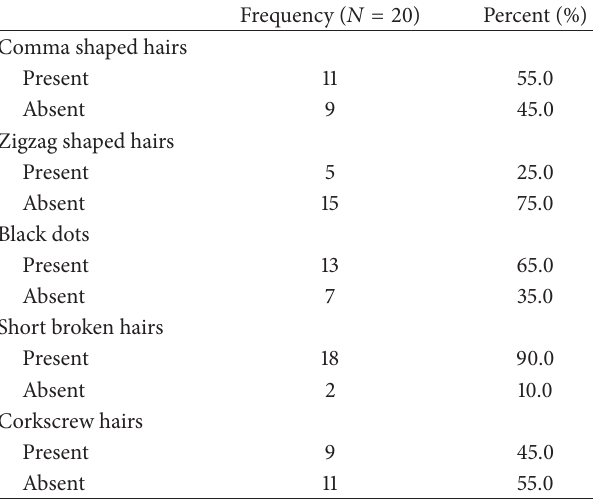
Table 1: Different trichoscopic features of tinea